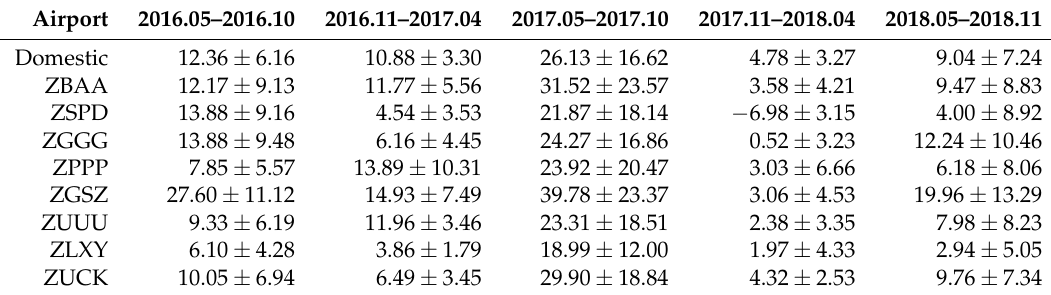
Table 1. Statistical analysis of delays by seasons. Columns report the average and standard deviation of delays, in the winter and summer seasons of 2016–2018, for the complete data set and for the top-eight airports in China.